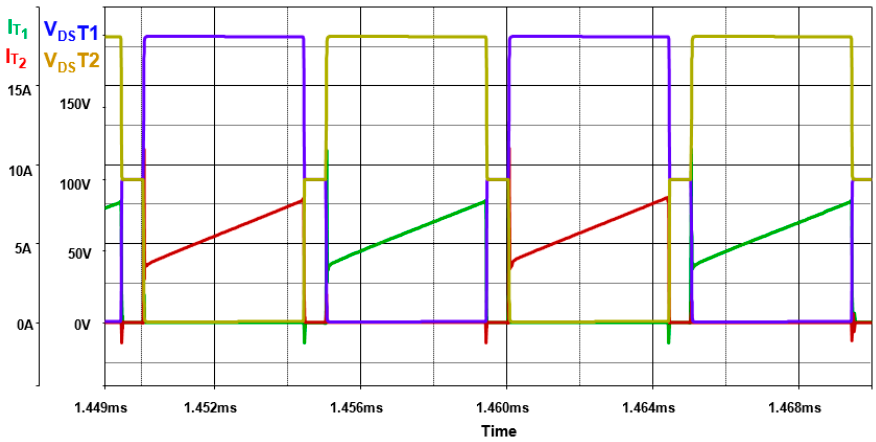
Figure 15. Voltage and current waveforms of the power transistors T 1 , T 2 (100% of output power)— simulation.